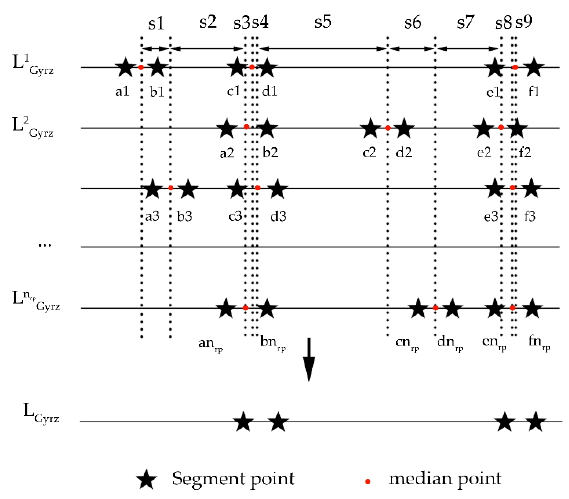
Figure 7. Example of an evidence framework.